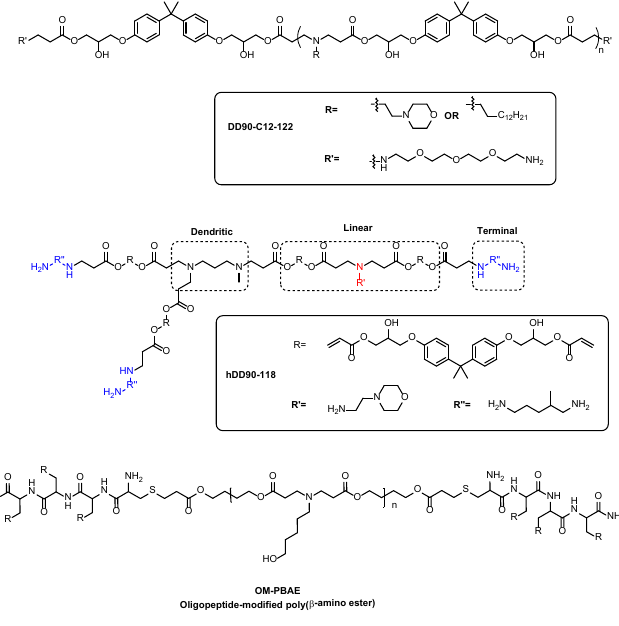
Figure 8. Representative chemical structure of